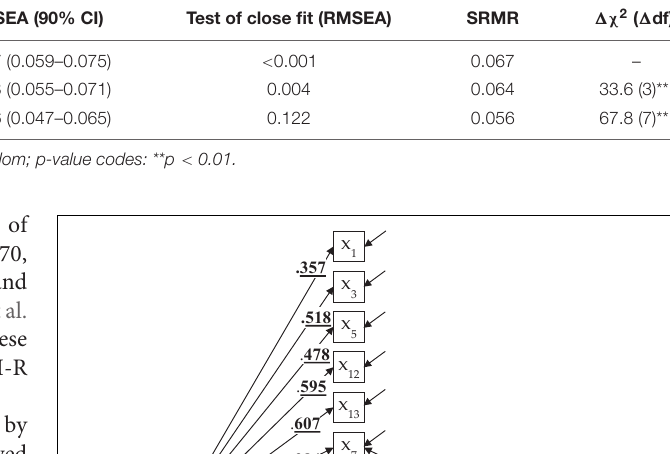
TABLE 1 | Goodness-of-fit indices for the UNI, 3CORR, and S-1(GRS) models. Model